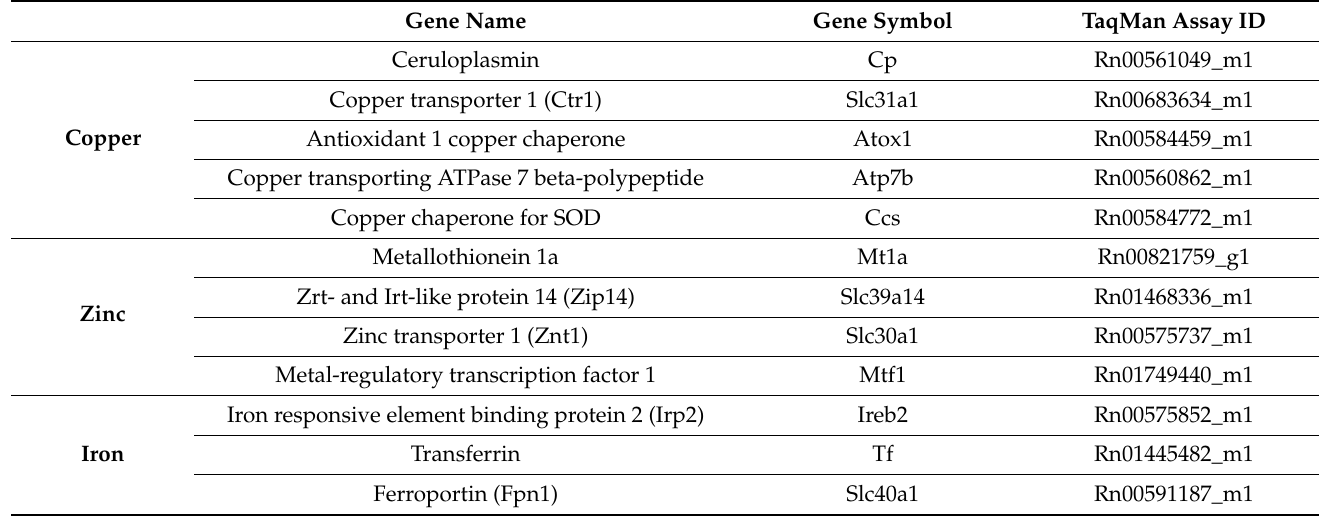
Table 1. List of TaqmanTM gene expression assays used for quantification of mRNA